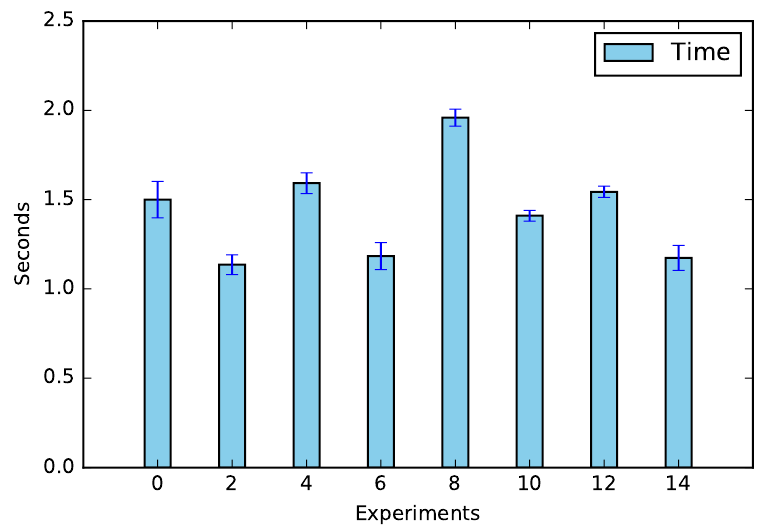
Figure 9. Time usage with and without the appliance